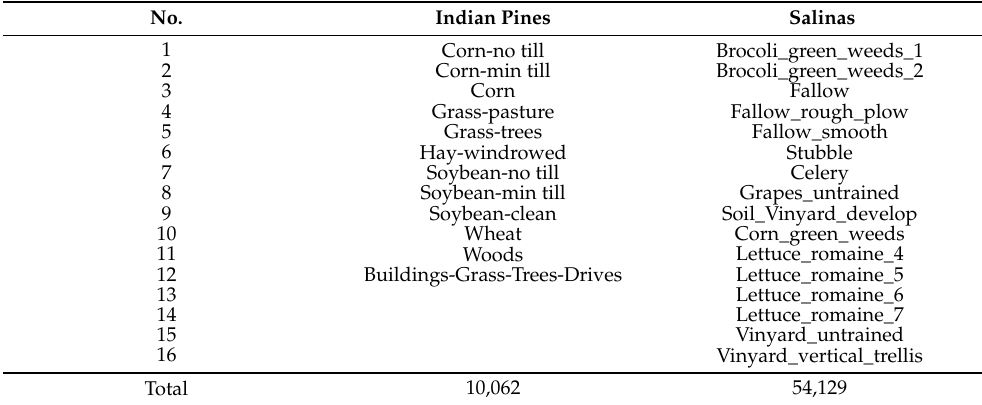
Figure 11. The name of categories and the corresponding number of labeled samples of datasets in Group B. Table 2. The selected categories of Indian Pines dataset and Salinas dataset for Case 1 and Case 2.